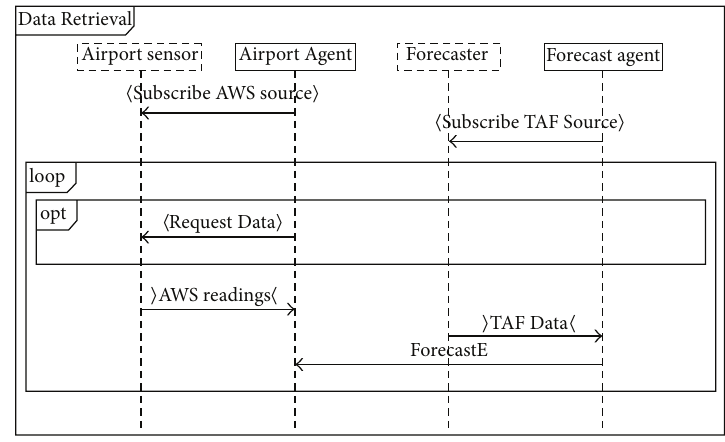
Figure 2: Data retrieval protocol diagram.